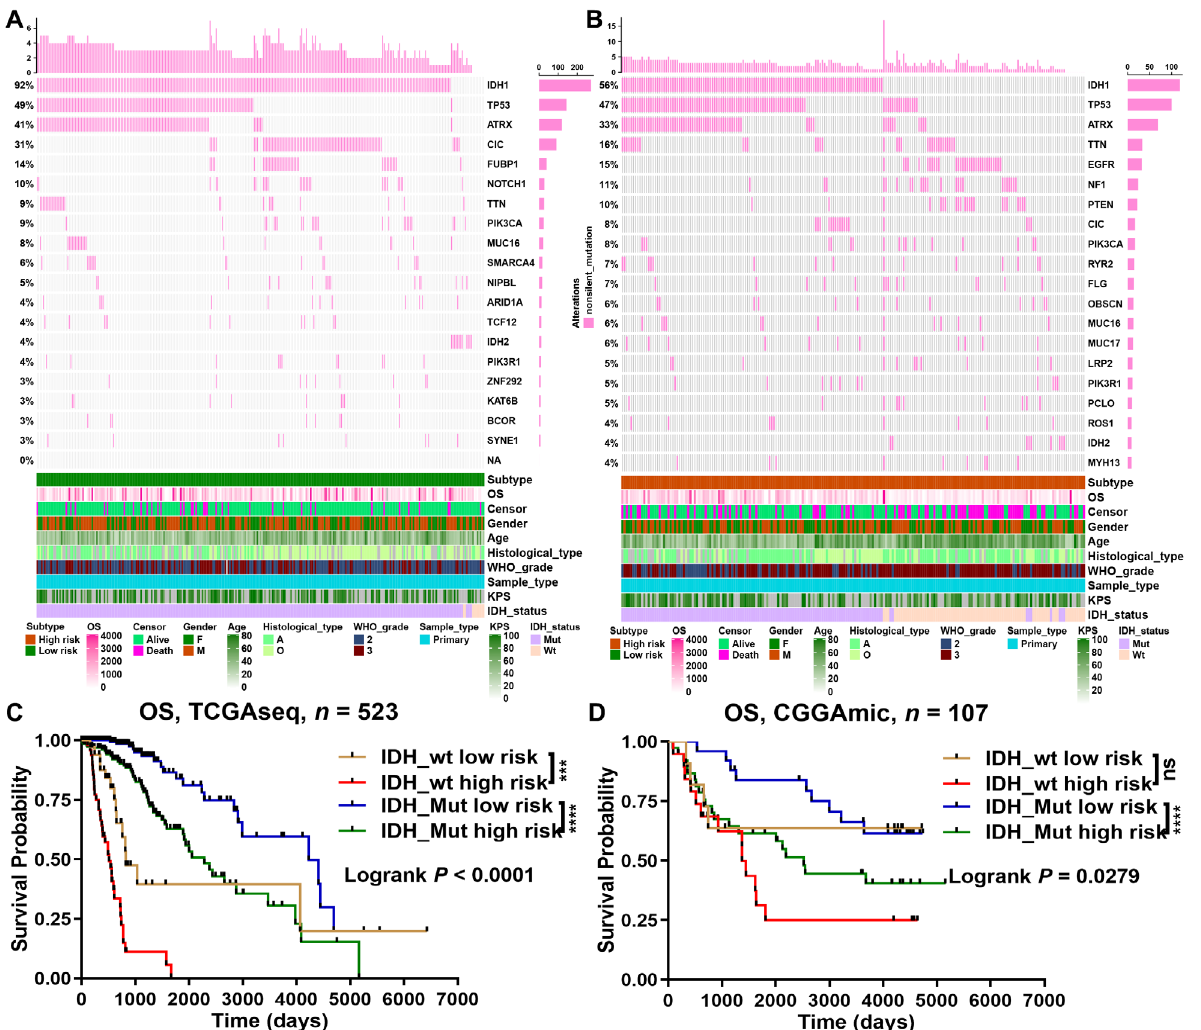
Figure 7. Genetic alteration analyses between the low- and high-risk groups of LGGs. Waterfall plot indicated gene mutations in the (A) low-risk and (B) high-risk groups; (C, D) prognostic evaluation of LGGs survival by IDH mutation status and m 6 A-related miRNA risk score in TCGA and CGGA